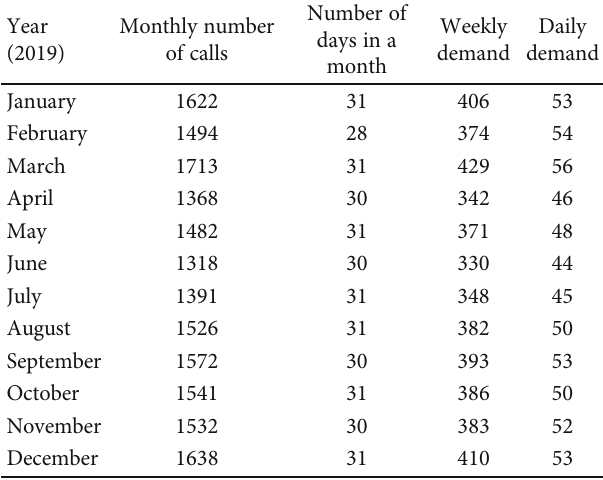
Table 8: Monthly, weekly, and daily projected number of calls for